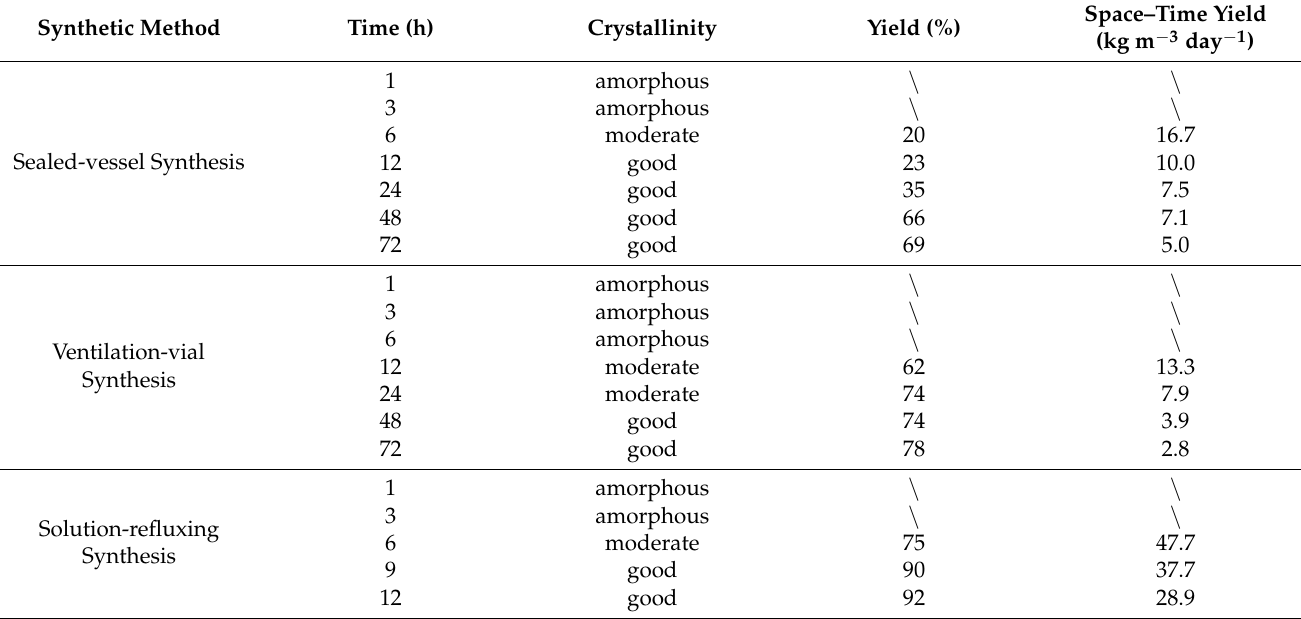
Table 1. Time-dependent syntheses of COF-300 via different synthetic